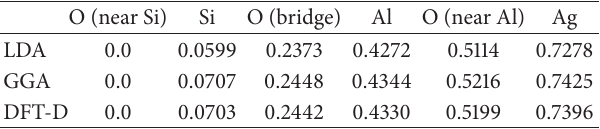
Table 3: Relative coordinates of atoms along the 𝑐 -axis. O (near Si)